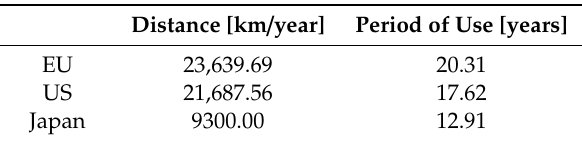
Table 4. Average annual distance covered by passenger car drivers and average period of vehicle use in the European Union, United States and Japan [140–143].